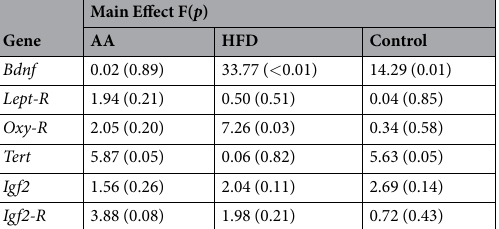
Table 4. Results from the ANOVAs used to examine promoter methylation in the sperm of sham and mTBI sons from the three paternal treatment groups.